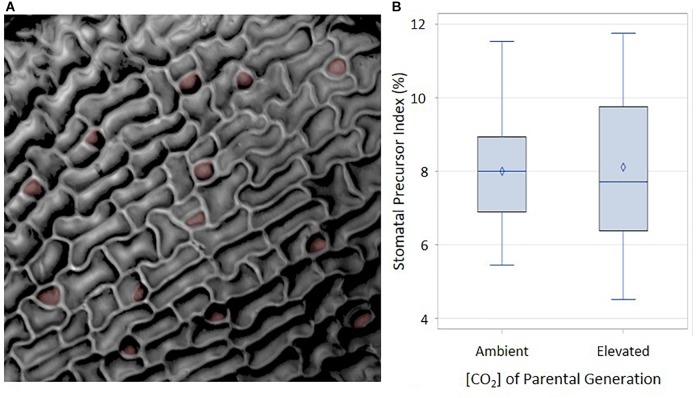
Abaxial distribution of SPI in ambient and elevated maternal conditions. (A) Reflective intensity of the surface of the abaxial side of a cotyledon. Stomatal precursors are false colored in red. (B) Using an α of 0.05, there was no significant difference between ambient and elevated maternal [CO2]. F = 0.02 and p-value of 0.9004.